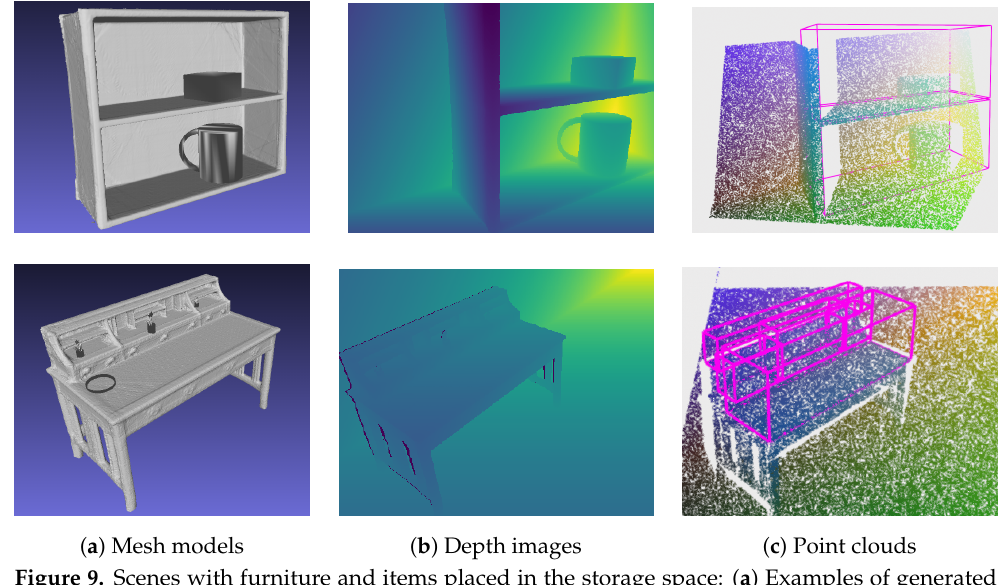
Figure 9. Scenes with furniture and items placed in the storage space: ( a ) Examples of generated cluttered scenes of a bookshelf and a table, ( b ) Generated depth images, ( c ) Generated point clouds with associated bounding boxes (purple colored